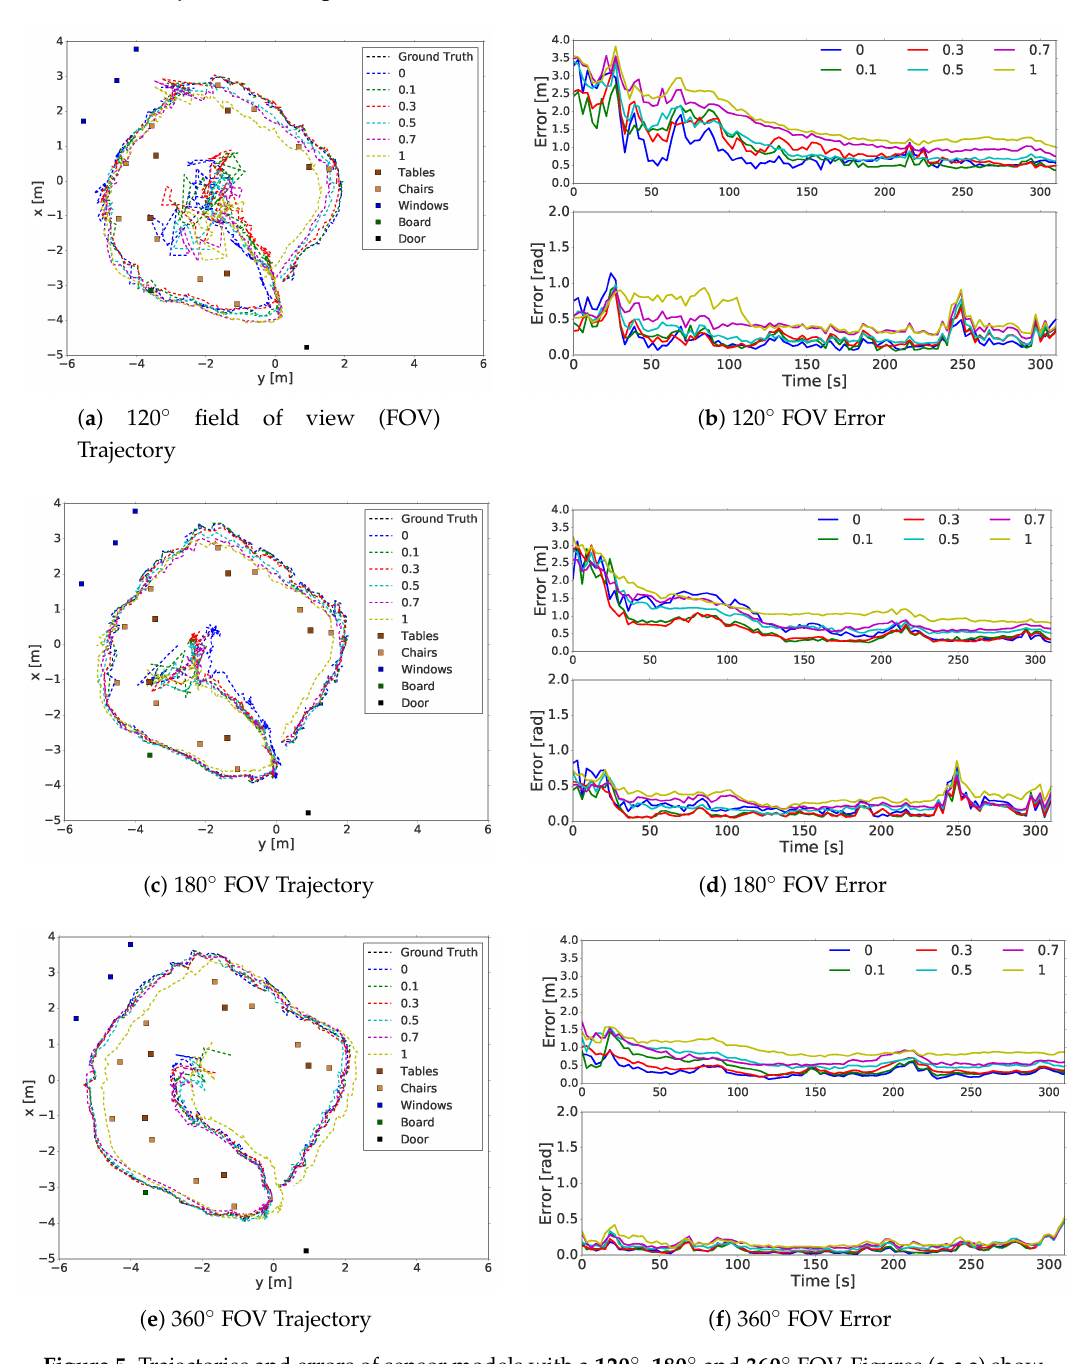
Figure 5. Trajectories and errors of sensor models with a 120 ◦ , 180 ◦ and 360 ◦ FOV. Figures ( a , c , e ) show the generated trajectory on maps with a noise of σ = 0 (blue), σ = 0.1(green), σ = 0.3 (red), σ = 0.5 (turquoise), σ = 0.7 (magenta) and σ = 1 (yellow). The ground truth is shown in black. Figures ( b , d , f ) show the localization errors of corresponding